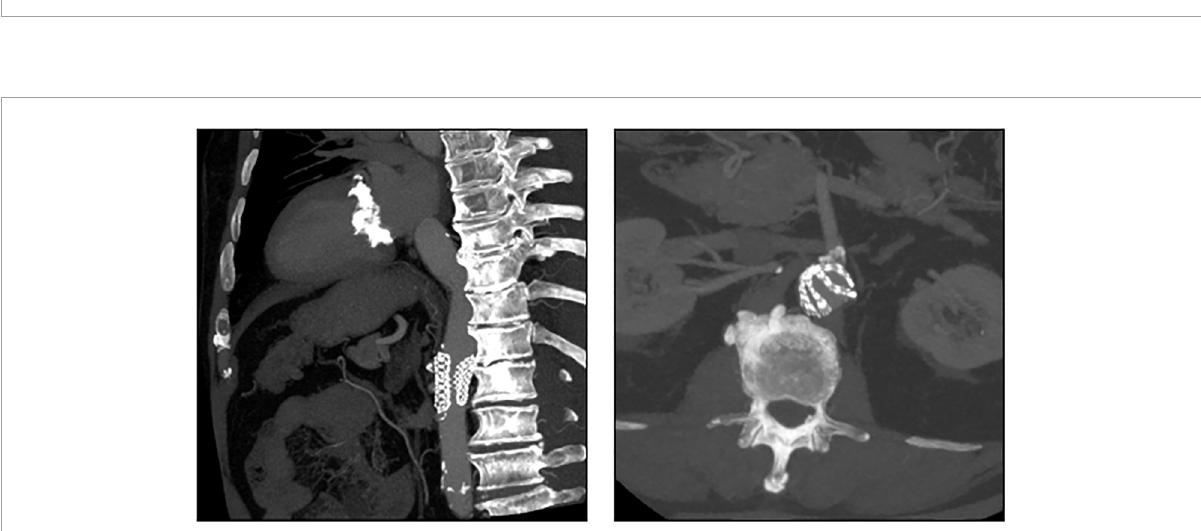
FIGURE4 CT images of a patient with embolization of an Evolut PRO. In this case (patient number 8 from Table 5 ), the snare used to pull the embolized Evolut PRO further into the ascending aorta was entangled in the valve frame. The bent Evolut PRO was eventually pulled into the descending aorta where the snare could be